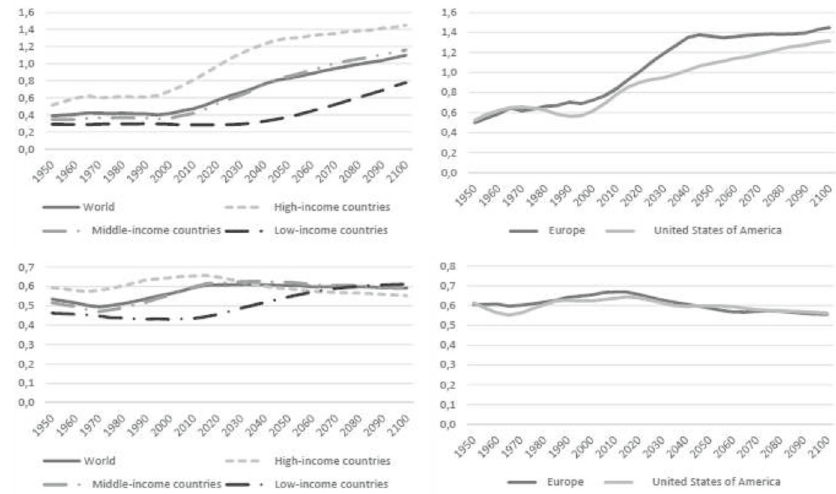
Fig. 1 Population ageing. First row: population 50 and above/population 20–49years of age. Second row: share of population 20–69 in total population. Source : United Nations, Population